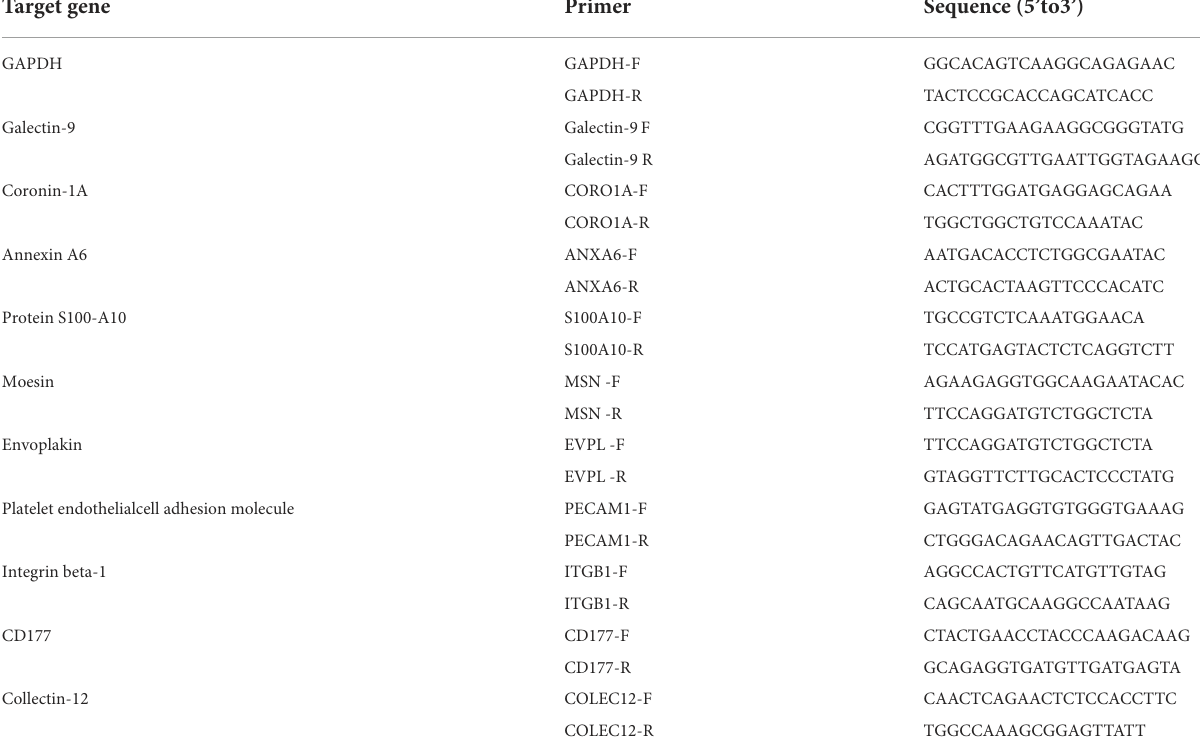
TABLE 2 Primers used in quantitative real-time PCR